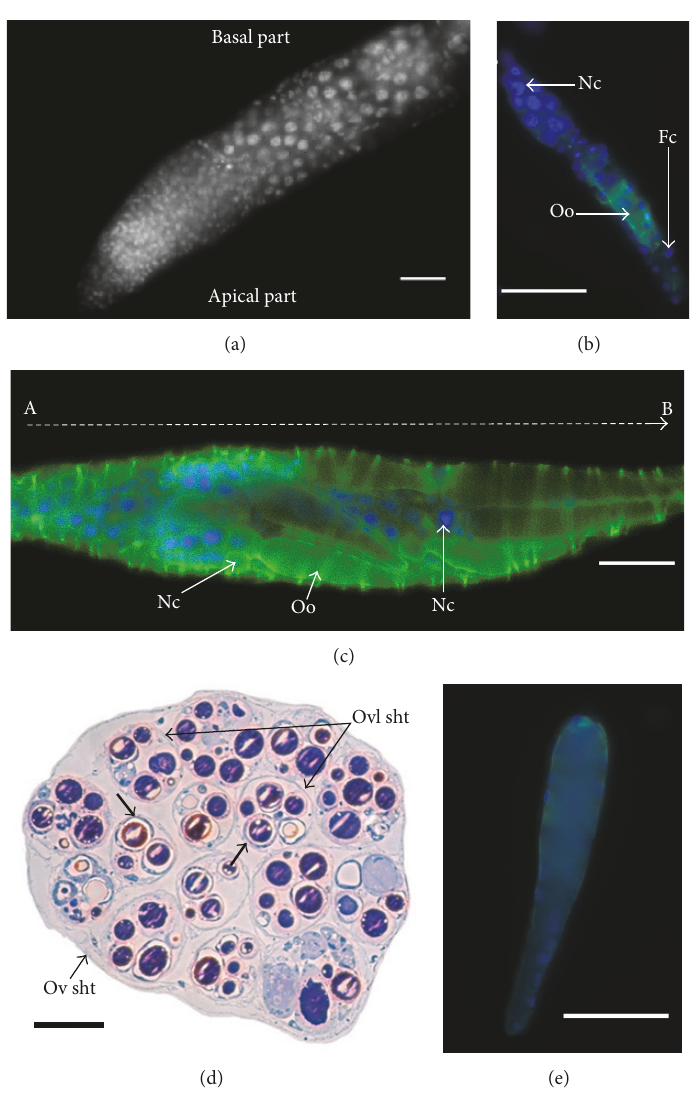
Figure 4: Oogenesis and ovarioles organization in Therophilus javanus . (a) View of the anterior region of T. javanus ovariole (germarium), indicating cell nuclei that increase in size along the germarium. Bar 20 𝜇 m. (b) Individual follicle taken out from a T. javanus ovariole. The pictureshowsthedispositionofthenursecells(Nc)atthetopoftheoocyte(Oo).Thenucleioffollicularcells(Fc)fromthesheathsurrounding the follicle can also be observed. Bar 50 𝜇 m. (c) Basal part of the ovariole of T. javanus . Follicles are in increasing development stages along the vitellarium (from A to B). On the left of the picture, follicles display small oocytes and trophocytes with a large nucleus. On the right, oocytes have increased in size thanks to progression of vitellogenesis. Note the network of actin fibers (in green) surrounding the egg chamber. Nurse cells (Nc); oocyte (Oo). Bar 50 𝜇 m. (d) Organization of the ovarioles and follicles within T. javanus ovaries: cross-sections of an ovary containing 15 ovarioles. The ovary is enveloped by the ovarian epithelial sheath (Ov sht) and each ovariole is surrounded by an epithelial sheath (Ovl sht). In the section, oocytes are in different stages within and between ovarioles. Some eggs with a chorion can be observed (shown by arrows). Semithin section stained with methylene blue. Bar 50 𝜇 m. (e) The mature egg of T. javanus . The egg has an ovoid shape and a slender tapering stalk at its posterior end. Bar 50 𝜇